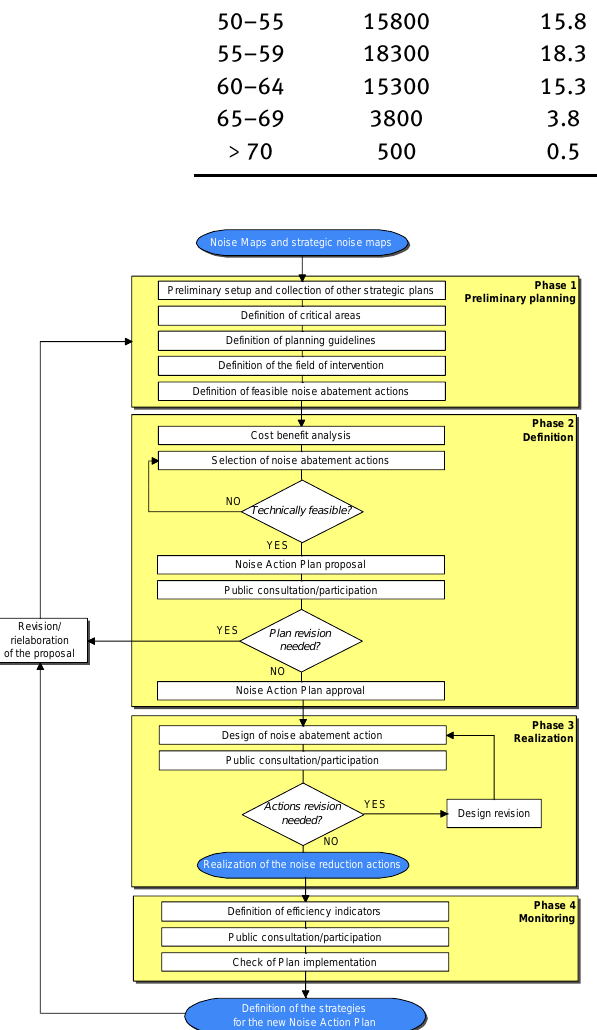
Figure 5: Flowchart for the elaboration of Noise Action Plans given by UNI/TR